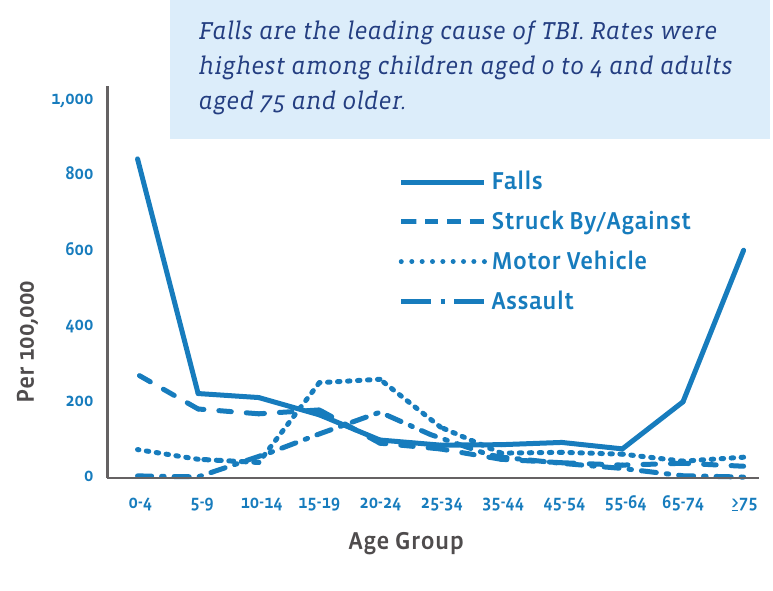
FIGURE 4: Estimated Average Annual Rates of Traumatic Brain Injury-Combined Emergency Department Visits, Hospitalizations, and Deaths, by External Cause, United States, 2002–2006 Falls are the leading cause of TBI. Rates were highest among children aged 0 to 4 and adults aged 75 and Falls struck By/Against motor Vehicle Assault